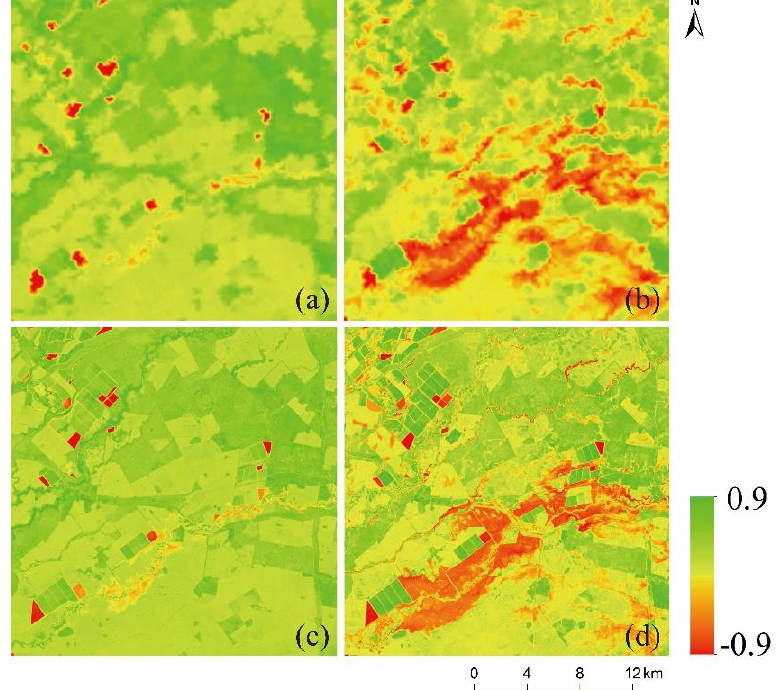
Figure 4. Testing datasets of flood areas. ( a , b ). MODIS_NDVI on 26 November and 12 December 2004; ( c , d ). Landsat_NDVI on 26 November and 12 December 2004.